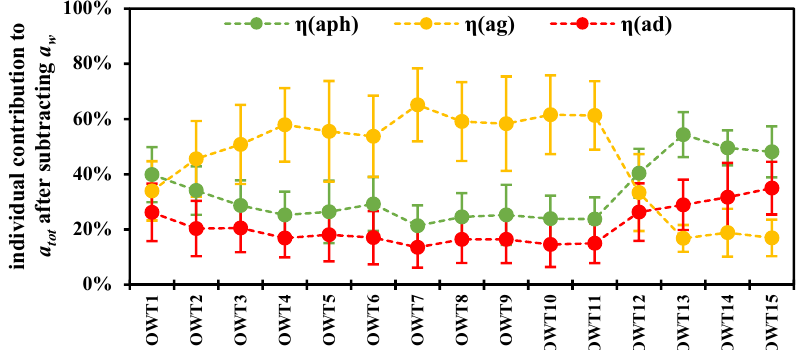
Figure 12. The contributions of the phytoplankton absorption coefficient at 440 nm a ph (440), CDOM absorption coefficient at 440 nm a g (440), and non-algal particle absorption coefficient at 440 nm a d (440) to total absorption a tot (440) after subtracting water contribution a w (440) for each dominant OWT class of the U-OWT. The error bars are the standard deviations of corresponding individual contributions.